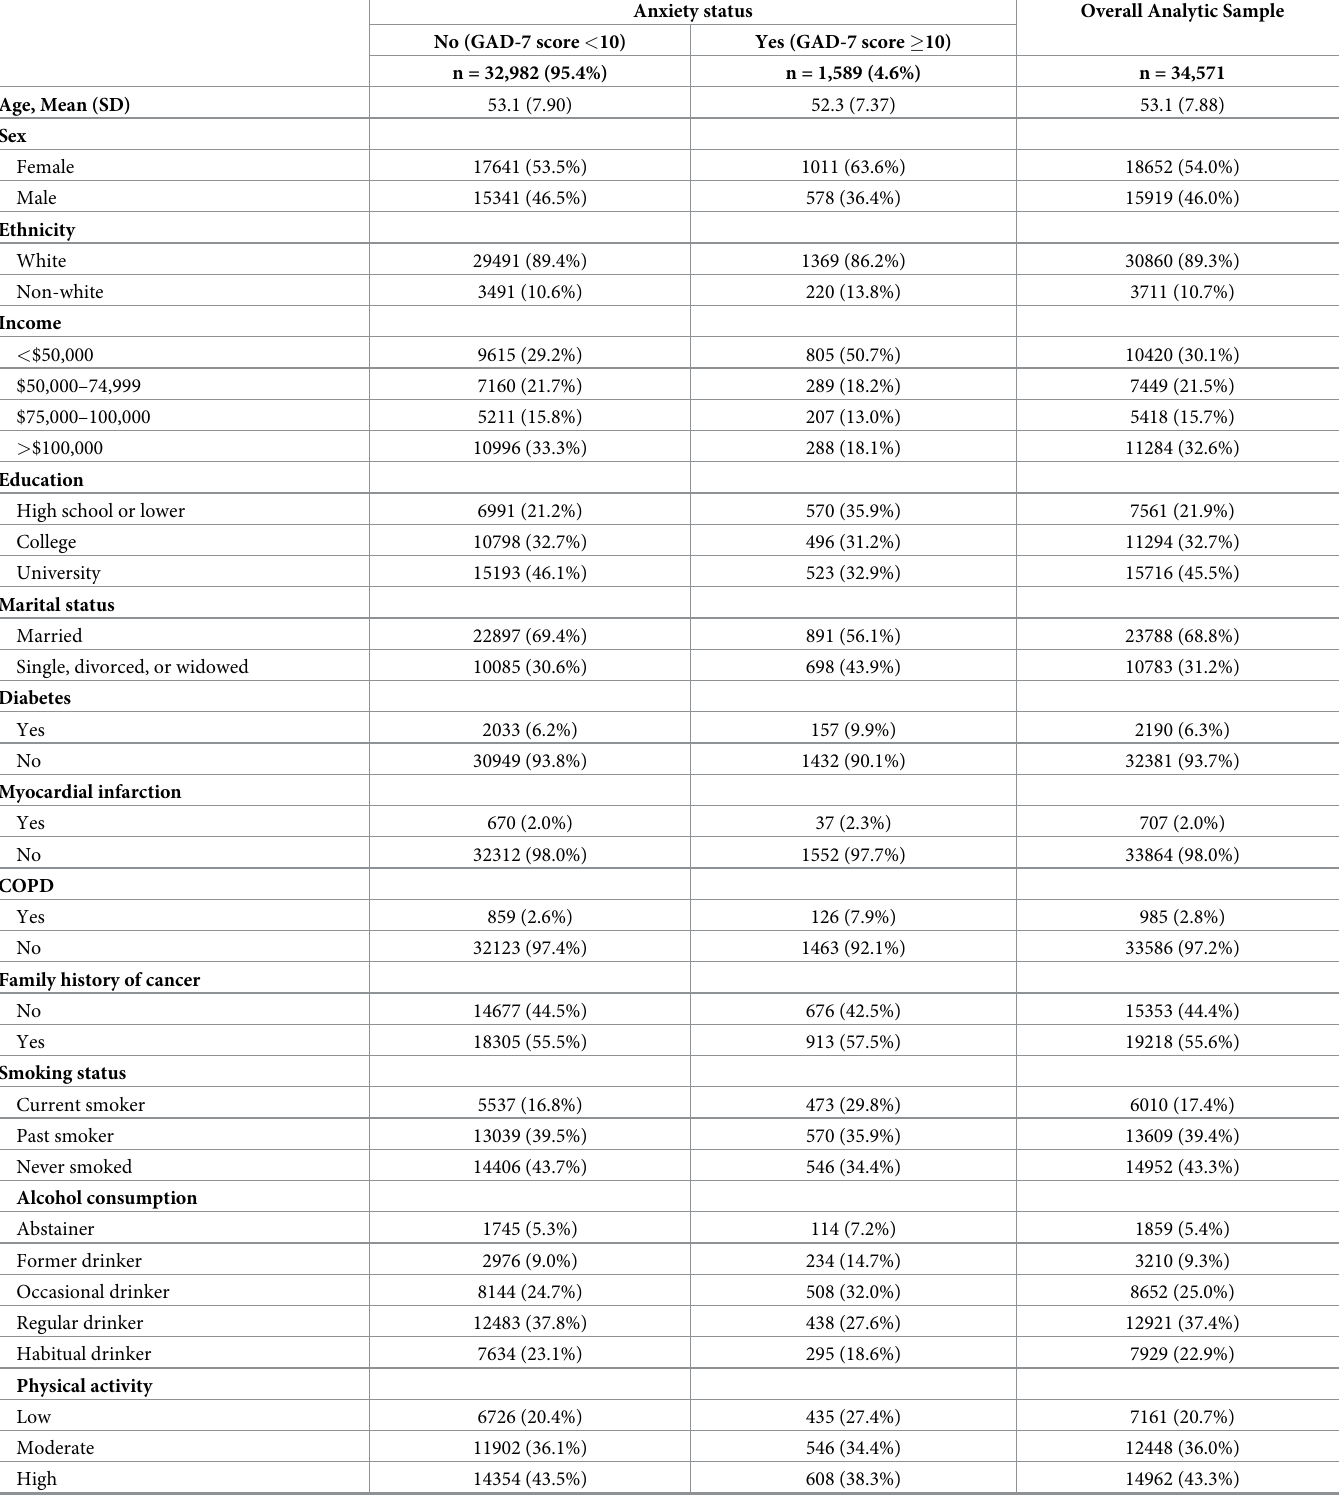
Table 2. Characteristics of the CARTaGENE sample with exclusion criteria applied with comparison of GAD-7